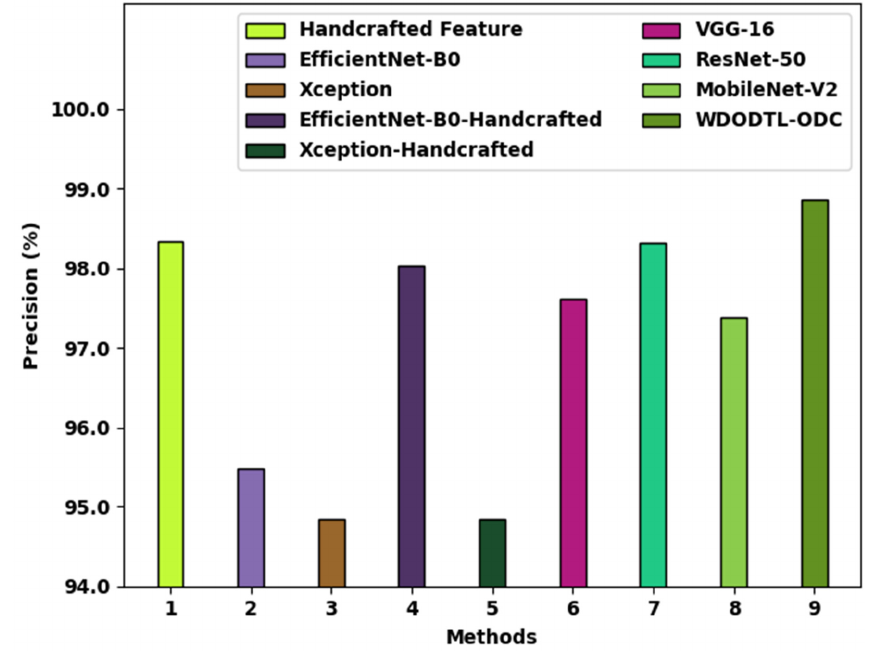
Figure 10. Prec n analysis of WDODTL-ODC approach with existing Figure 10. 𝑃𝑟𝑒𝑐 (cid:3041) analysis of WDODTL-ODC approach with existing algorithms. Figure 11 illustrates a brief 𝑟𝑒𝑐𝑎 (cid:3039) investigation of the WDODTL-ODC system with existing techniques. The figure implied that the handcrafted feature, EfficientNet-B0, and VGG-16 models have resulted in least classification 𝑟𝑒𝑐𝑎 (cid:3039) of 98.17%, 97.37%, and 97.30% correspondingly. Also, the Xception, EfficientNet-B0-Handcrafted, Xception-Hand- crafted, and ResNet-50 models have attained somewhat enhanced 𝑟𝑒𝑐𝑎 (cid:3039) values of 95.85%, 98.39%, 96.64%, and 94.16% correspondingly. Eventually, the MobileNet-v2 algo- rithm has revealed reasonable performance with 𝑟𝑒𝑐𝑎 (cid:3039) of 98.33%, the WDODTL-ODC methodology has been able to maximal 𝑟𝑒𝑐𝑎 (cid:3039) of 98.69%.